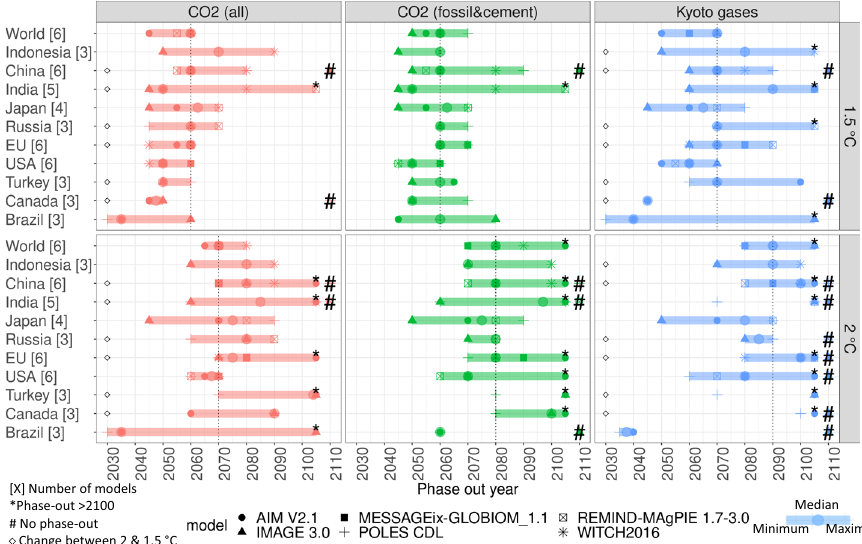
Fig. 1 Year when projected emissions reach net zero, per country (number of models representing that country between brackets), for 2 °C and 1.5 °C scenarios, for CO 2 emissions, CO 2 emissions from fossil fuels and cement (energy and industrial processes), and total GHG emissions (Kyoto Gases, including land-use emissions). Individual models are indicated by symbols, whereas the bars show the minimum – maximum range (enlarged circles: model median). In some cases, individual models show a phase-out after 2100 in the extrapolated data (indicated by an asterisk) or no phase-out at all (#). Diamonds plotted at the 2030 mark indicate a change between the 2 °C and 1.5 °C scenario in terms of a country reaching net zero earlier than, similar to, or later than global average. Vertical dotted lines indicate the global average phase-out